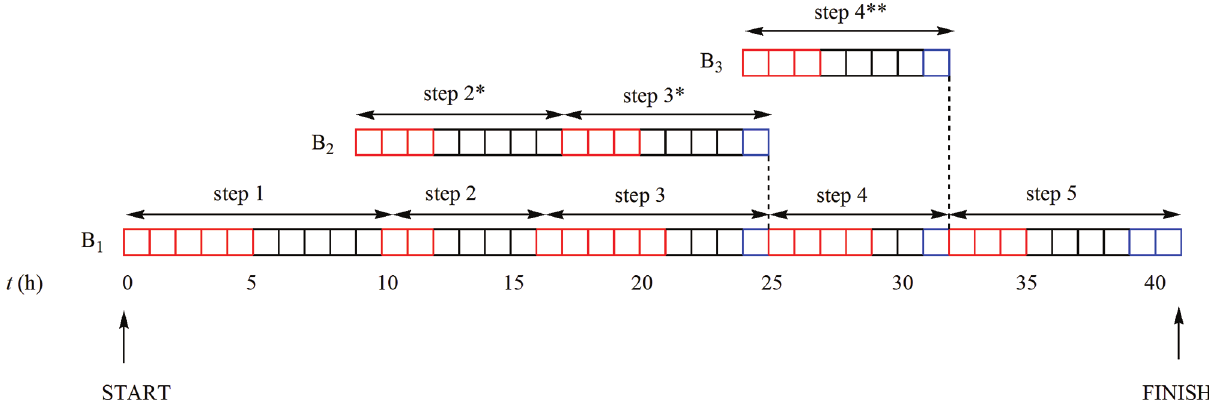
(5 steps), B (2 steps), and 1 2